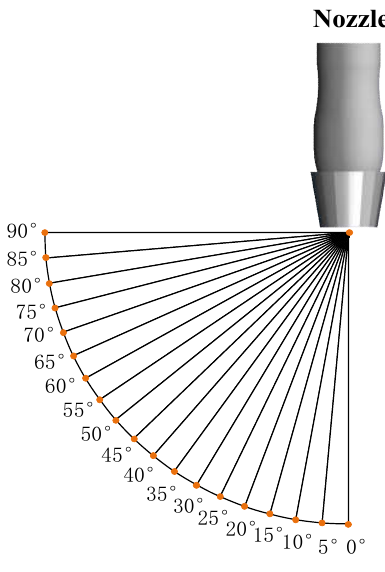
Figure 10 . Number of adjusting plates outside the nozzle.